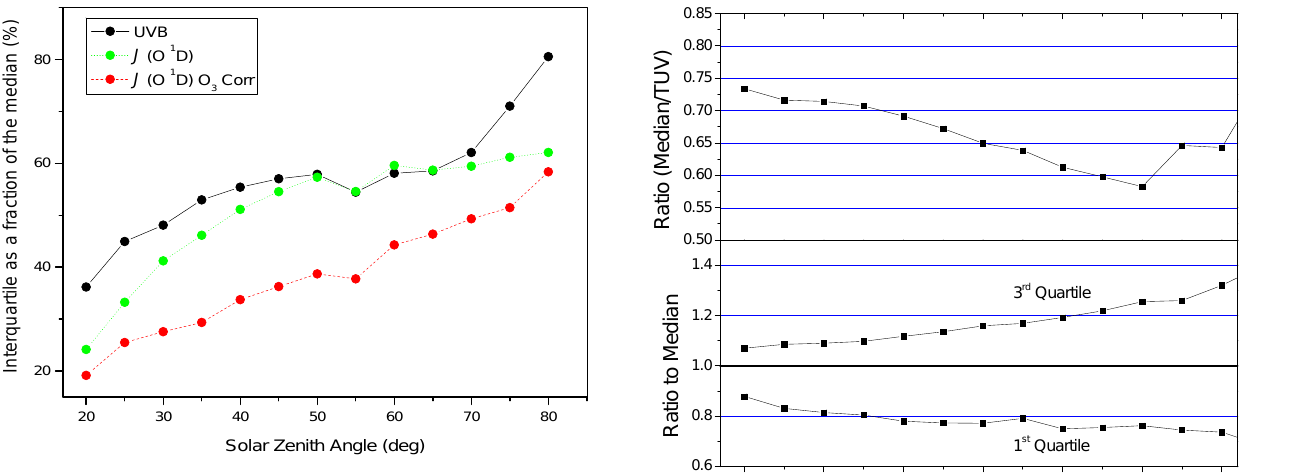
Figure 6. The interquartile (75–25%) difference as a percentage of the median value as a function of solar zenith angle. UVB is the global irradiance, and the other two terms are the derived photolysis rates, with the red curve measurements having been corrected to a constant column ozone amount.